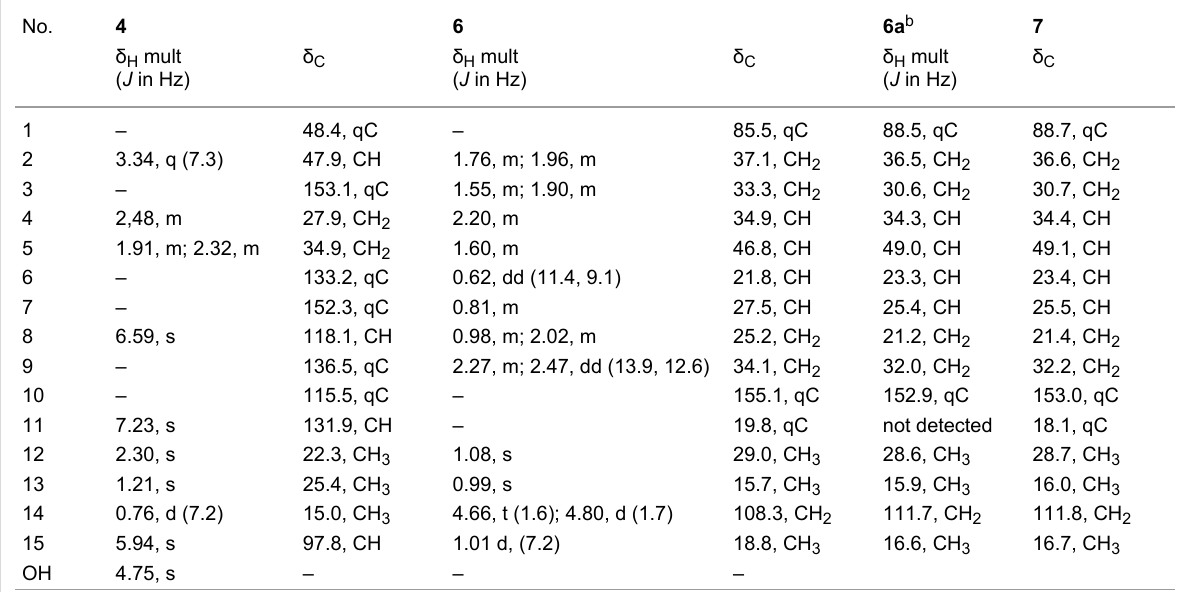
Table 2: 1 H and 13 C NMR data of 4 a and 6 a and 13 C NMR data of 6a b and 7 a recorded in CDCl 3 . No.